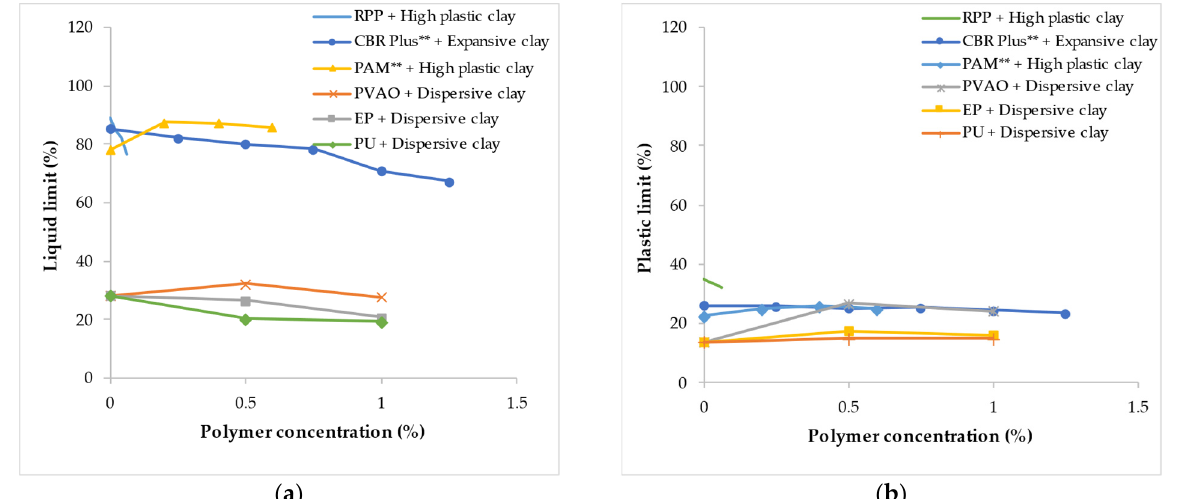
Figure 2. Variation in the Atterberg limit resulting from polymer inclusion at low concentration: ( a ) Liquid limit; ( b ) Plastic limit (** indicates polymer concentration as a % of weight of water). Note: these figures were created with data obtained from [96,102,144,145].